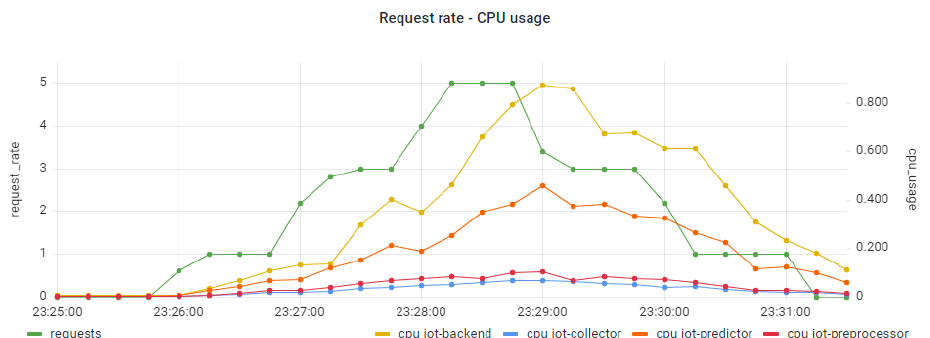
Figure 11. Request rate and latencies variation under the bursty workload.